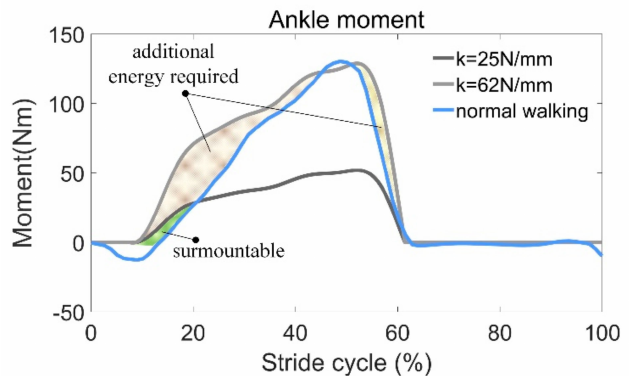
Figure 13. Comparison between the required joint moment and the calculated moment contributed by the